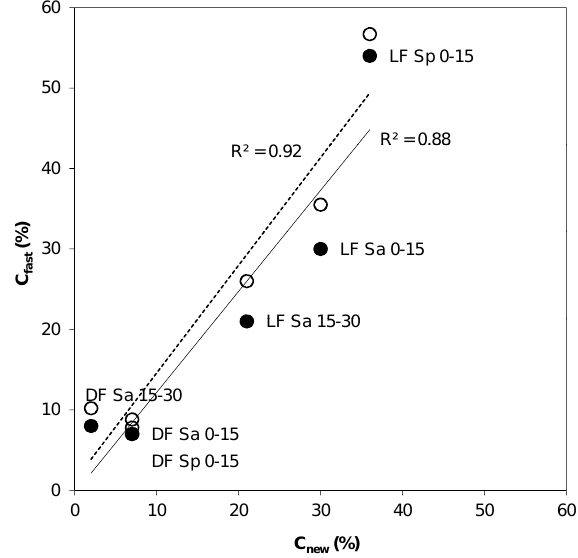
Fig. 2. The percentage of each soil fraction that is new (carbon in- corporated since the experiment began; C new ) versus the percentage of each soil fraction that is fast cycling (C fast ) in 1997. The value of C new is independent of the steady-state assumption because it was calculated directly from the soil δ 13 C value. C new explains 88 and 92% of the variation in C fast under steady-state conditions and non-steady-state conditions, respectively ( n = 6, P < 0 . 01 for each case). Legend: LF, light fraction; DF, dense fraction; Sa, sandstone; Sp, serpentine. Filled circles and solid line represent steady-state conditions. Open circles (dashed line) represent non-steady-state conditions; the open circle is right above the filled circle for the same fraction/soil/depth